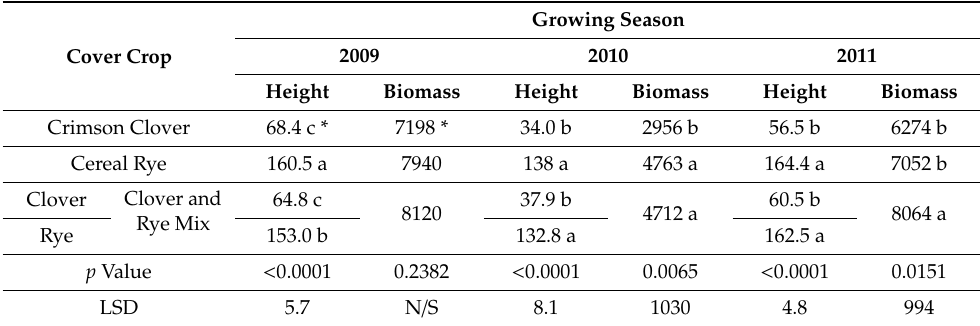
Table 3. Height (cm) and cover crop biomass (kg ha − 1 ) on dry basis during three growing seasons.